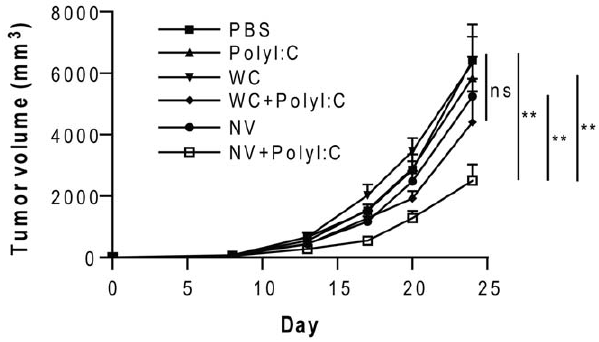
Figure 2. Effect on primary tumor growth of therapeutic vaccination with tumor-derived NVs. Mice (n=7 per group) that were pre-established with B16BL6 melanoma of the skin received 10 m g of antigens (NVs or whole cell lysates) with or without 50 m g polyI:C per mouse. The mice were subjected to measurements of tumor growth. WC, melanoma whole cell lysates. ** P , 0.01; ns, not